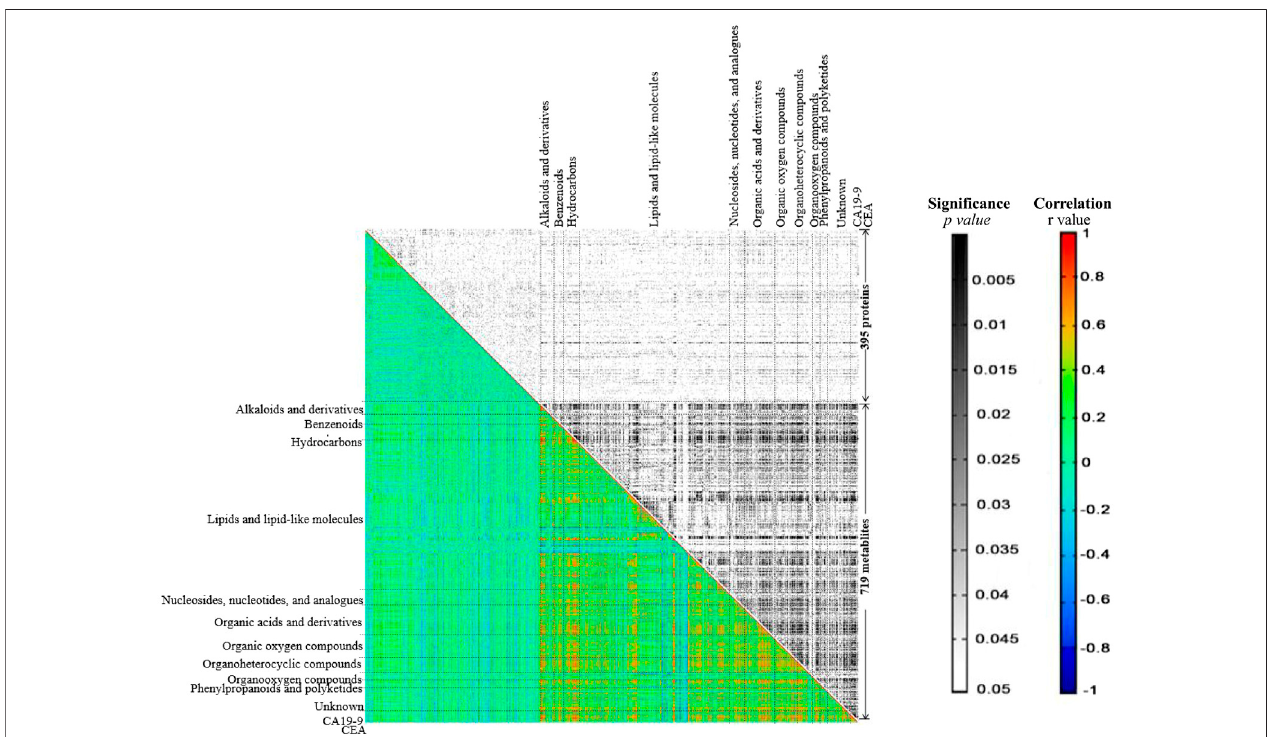
FIGURE4| Theheat-mapgeneratedfromcorrelationanalysis. X and Y -axeswerecategorizedintoproteins/metabolites/CA19-9/CEA. Intheblackandwhitearea rectangles represent p -values resulting from Pearson correlation coef fi cient, while in the colored area rectangles represent r values respective to Pearson correlation coef fi cient